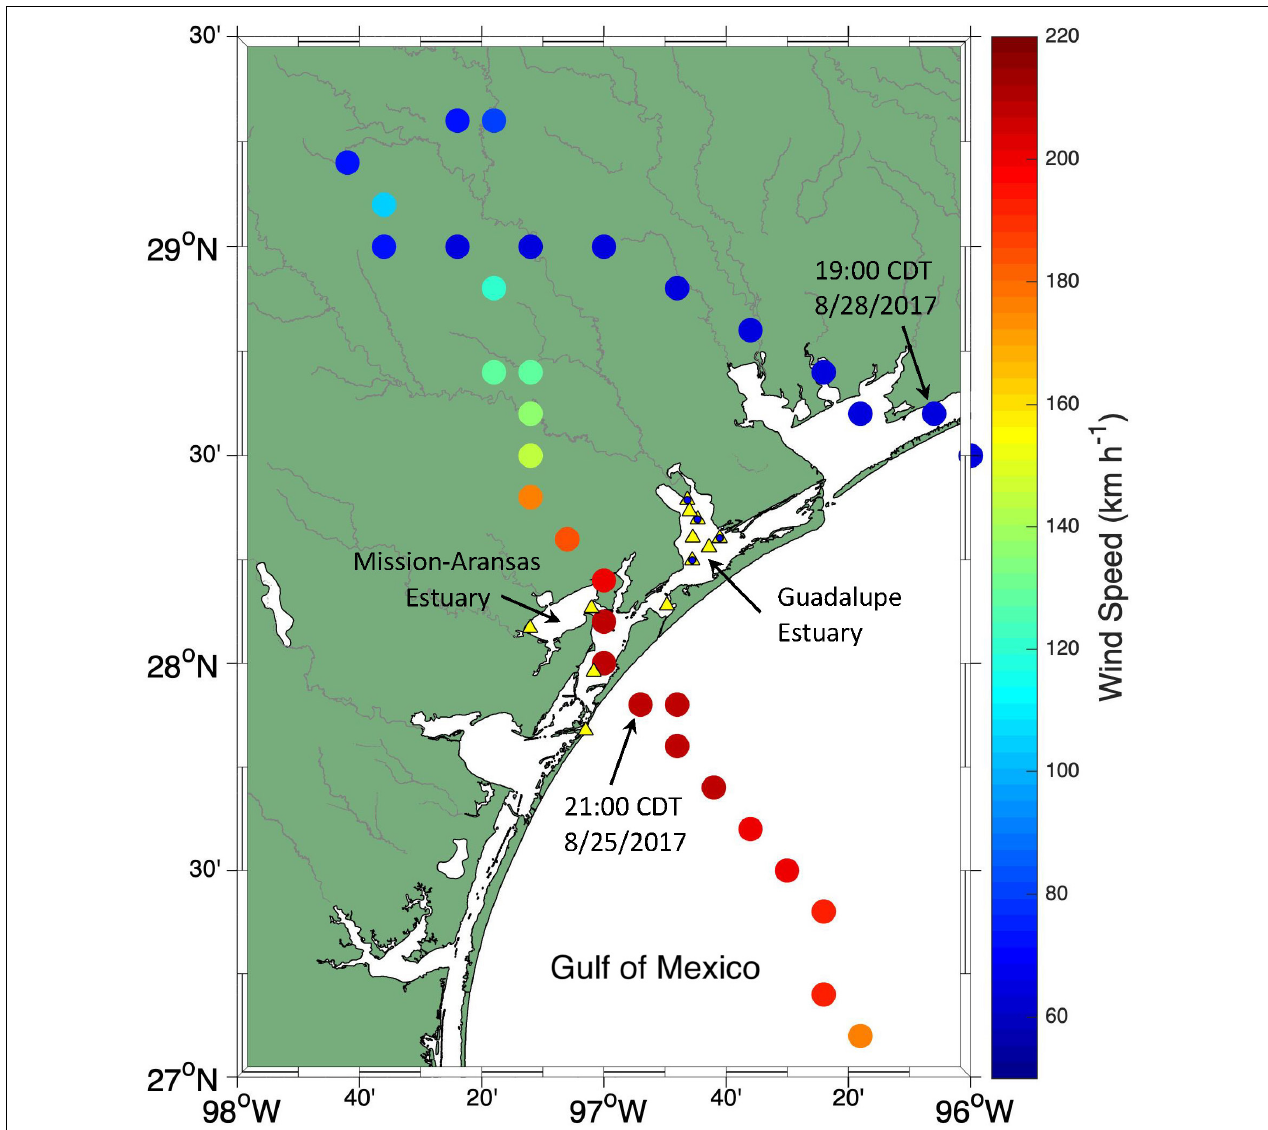
FIGURE 1 | The track of Hurricane Harvey and wind speed (colorbar). The sampling stations in Mission-Aransas Estuary (MAE) and Guadalupe Estuary (GE) are shown in yellow triangles. The blue circles superimposed on the triangles in GE represent quarterly sampling stations (see text for